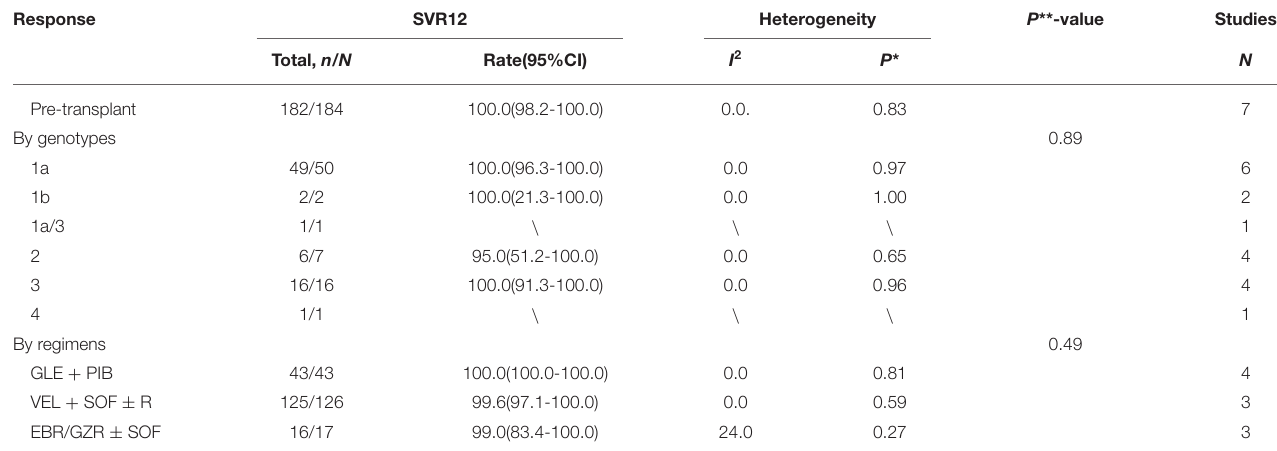
TABLE 4 | Subgroup analysis of SVR12 for pre-transplant.